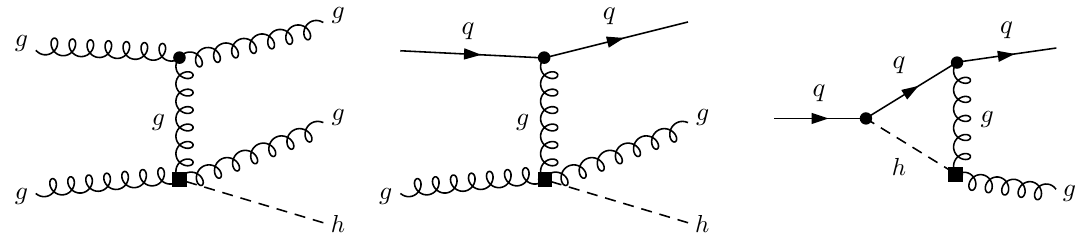
Figure 1 . Left: tree-level graphs that give rise to pp ! h + 2 j production at the LHC. Right: example one-loop diagram that contributes for instance to the nEDM. The black squares indicate insertions of the CP-violating dimension-six operator